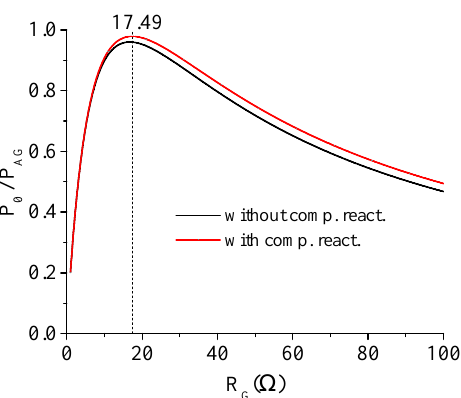
Figure 11. Total output power calculated for case 4 by varying the generator impedance when the loads are those maximizing G P